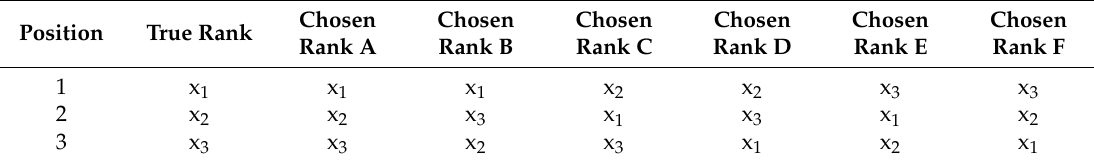
Table 2. Possible misrepresentations of player rank-ordering within team x.